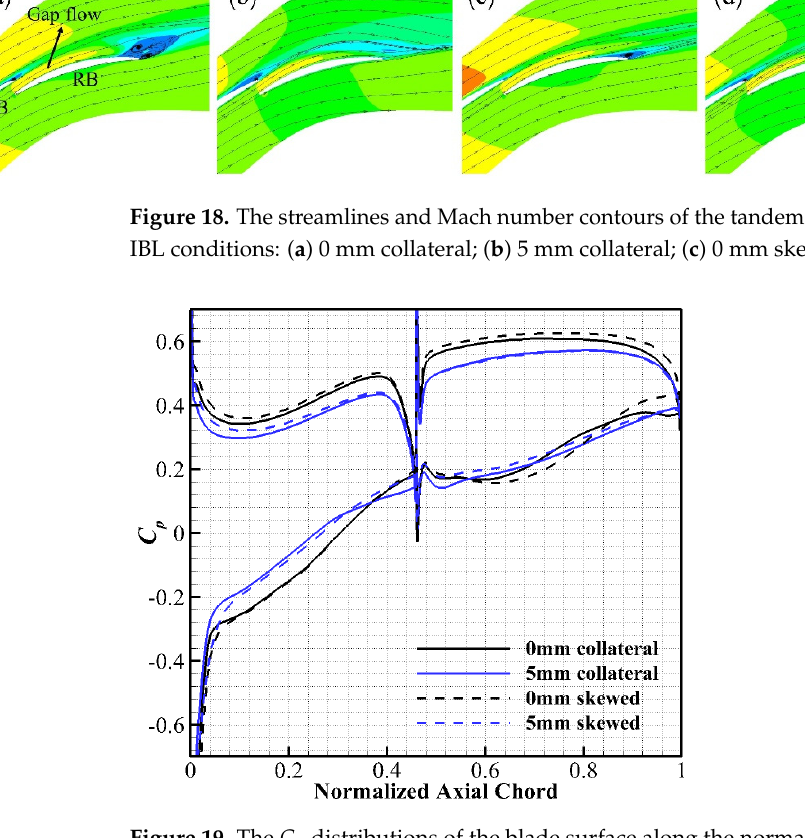
Figure 19. The C p distributions of the blade surface along the normalized axial chord of the tandem cascade at 5% h .